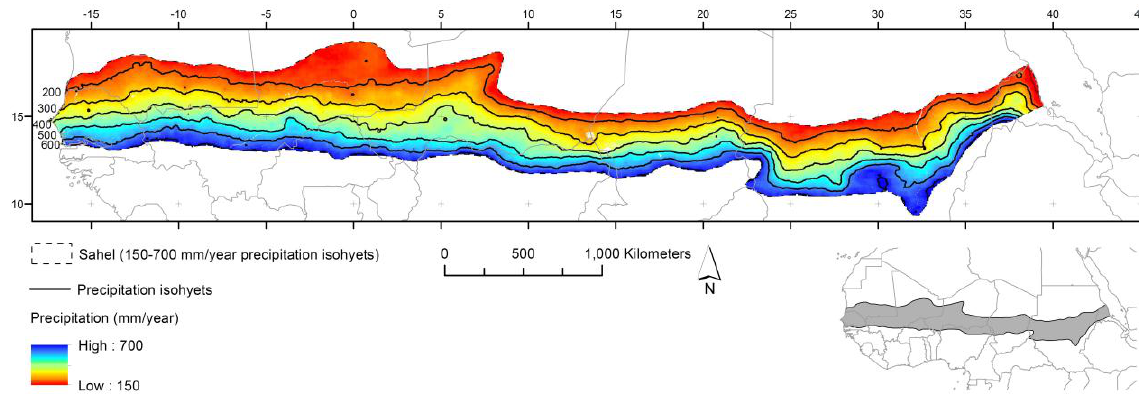
Figure 1. Sahel delineation (150–700 mm/year precipitation isohyets) and annual average precipitation (Climate Prediction Center Merged Analysis of Precipitation, CMAP